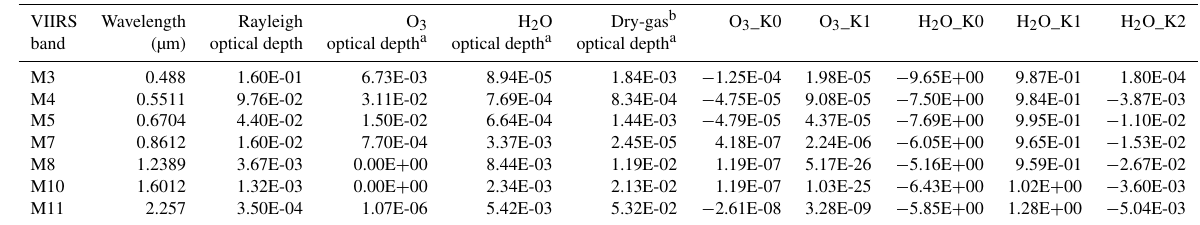
Table 5. Gas absorption coefficients and climatology for VIIRS.